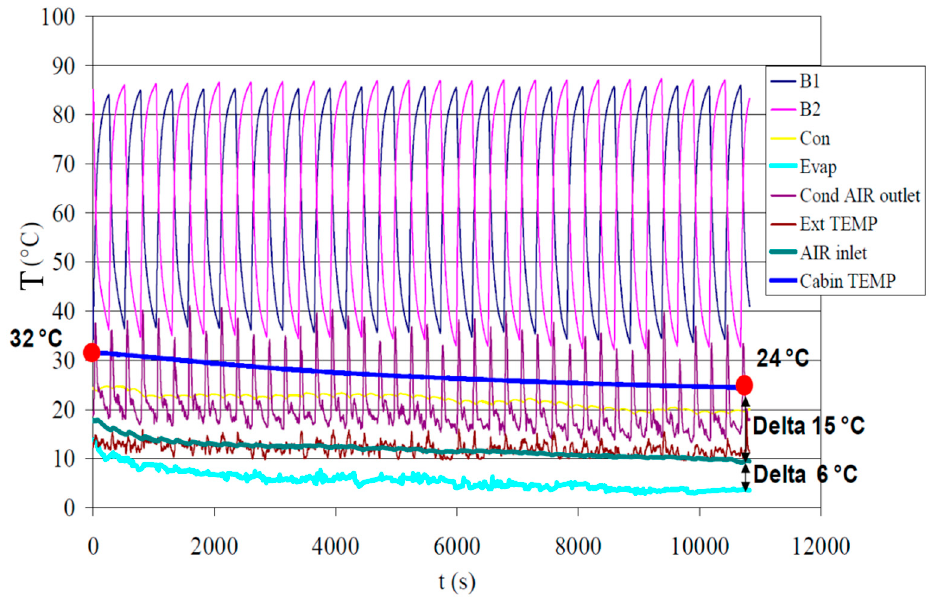
Figure 12 The temporal temperature profiles of the cabin and the major components of the adsorption system [8].